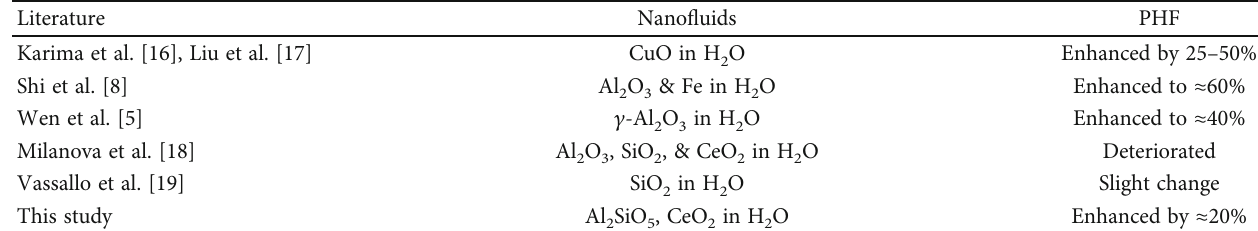
Table 3: Comparison with earlier